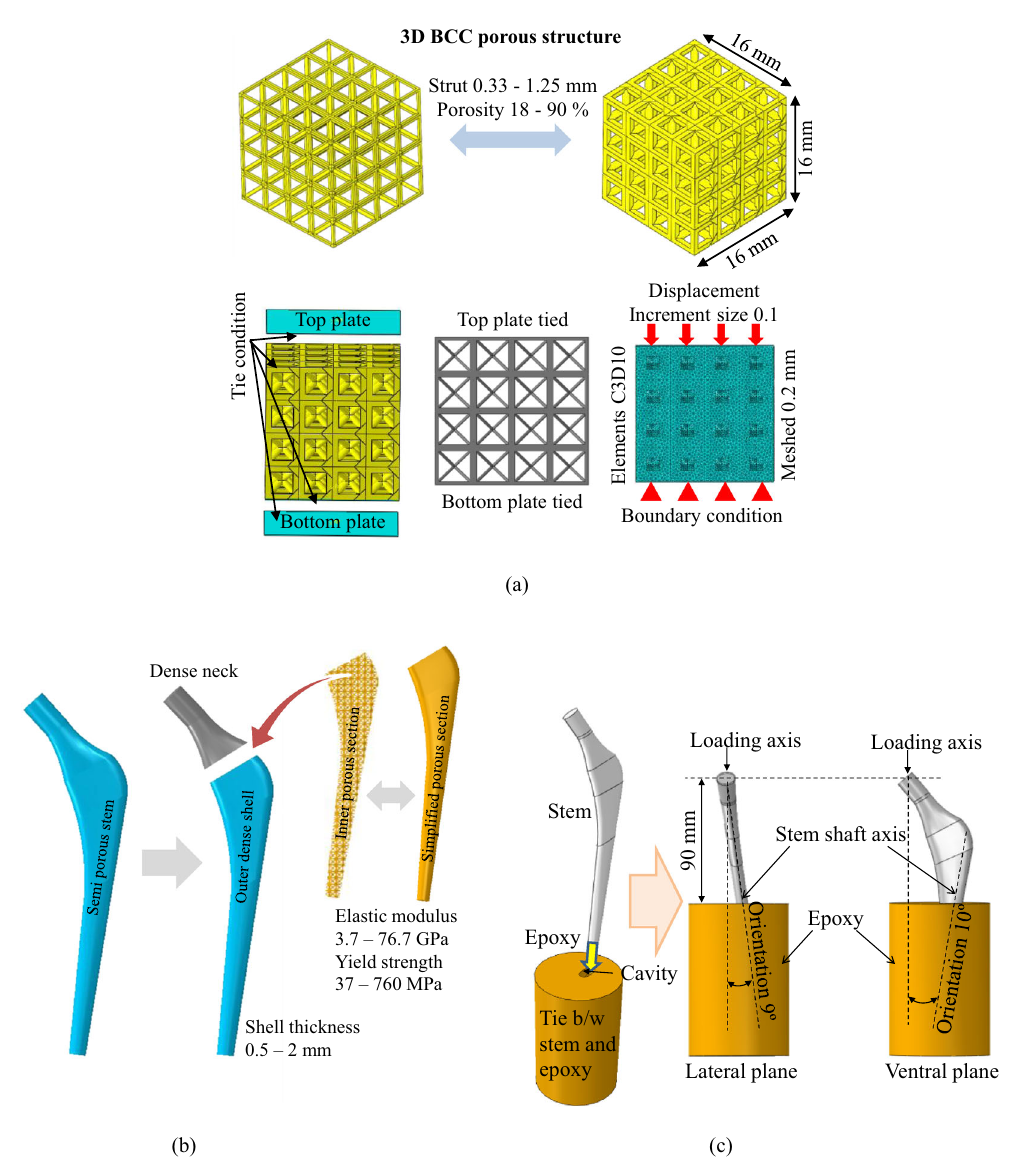
Fig. 2 Finite element models; a details of porosity, loading and boundary conditions of BCC porous structures, b construction of 3D fi nite element model of the femoral stem and c testing method of femoral stem according to ISO 7206-4